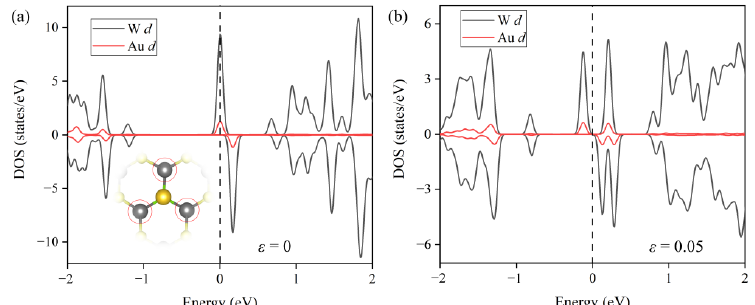
Figure 4. Partial density of states (PDOS) of the d orbitals of the single Au atom and its three nearest neighboring W atoms (circled with the red lines shown in the inset) in Au/WSSe ( a ) without and ( b ) with external tensile strain ( ε =